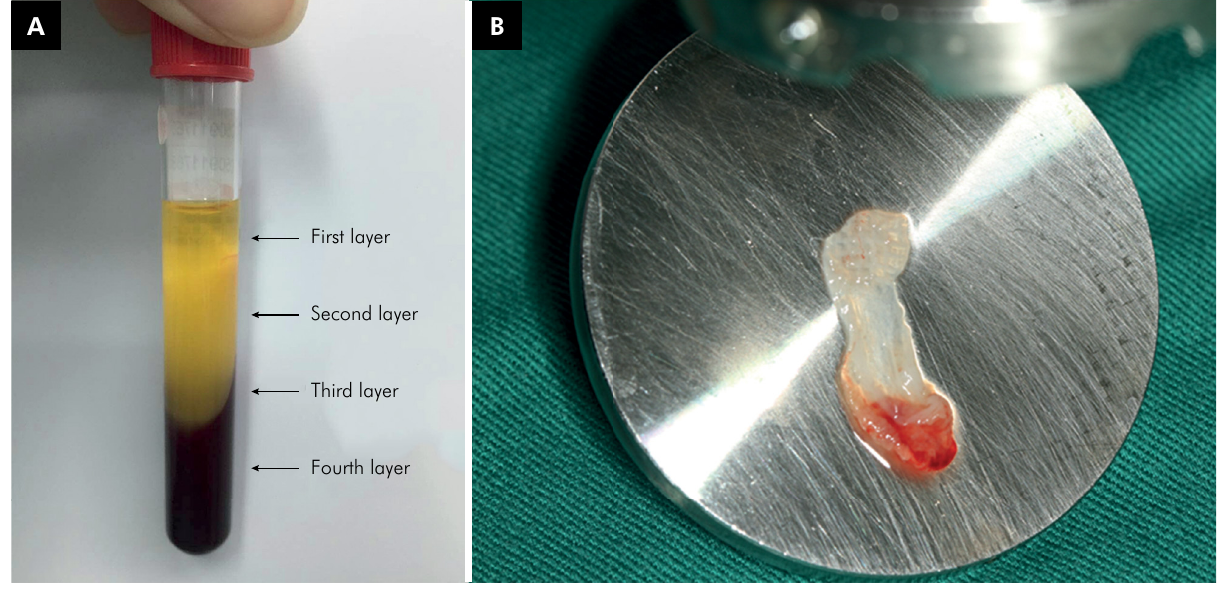
Figure 1. (A). CGF after centrifugation of blood; (B). CGF